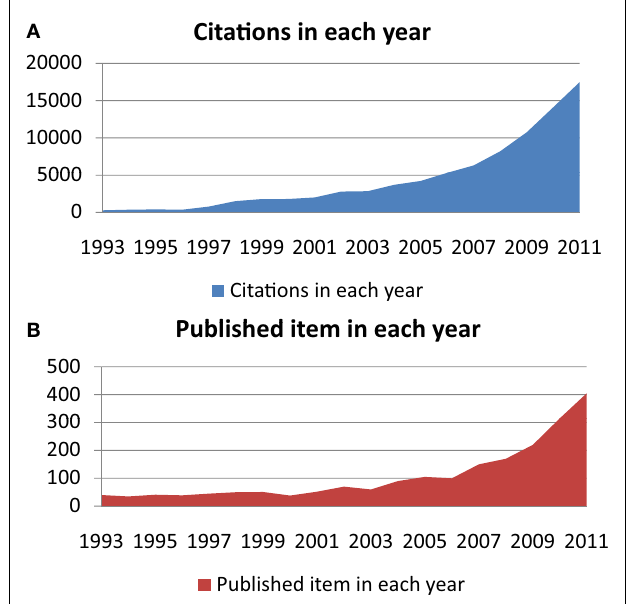
FIGURE 1 | Using the key words “human gut microbiota” or “human fecal flora” and using the ISIWeb of Knowledge database, (A) shows citations in each year regarding this subject, and (B) shows the number of published items each year, both between 1993 and